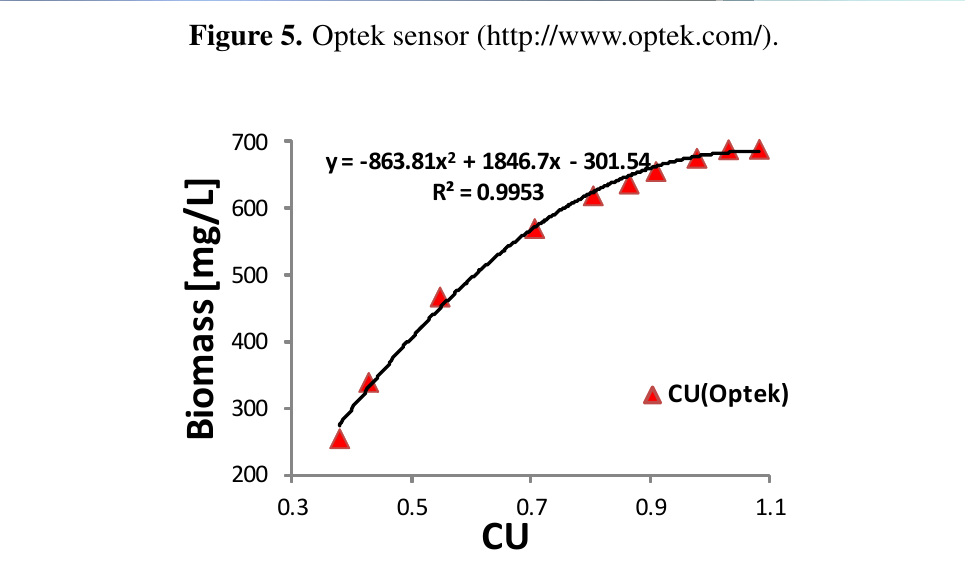
Figure 6. Correlation between the CU (Optek) and the dry biomass of the strain Dunaliella tertiolecta